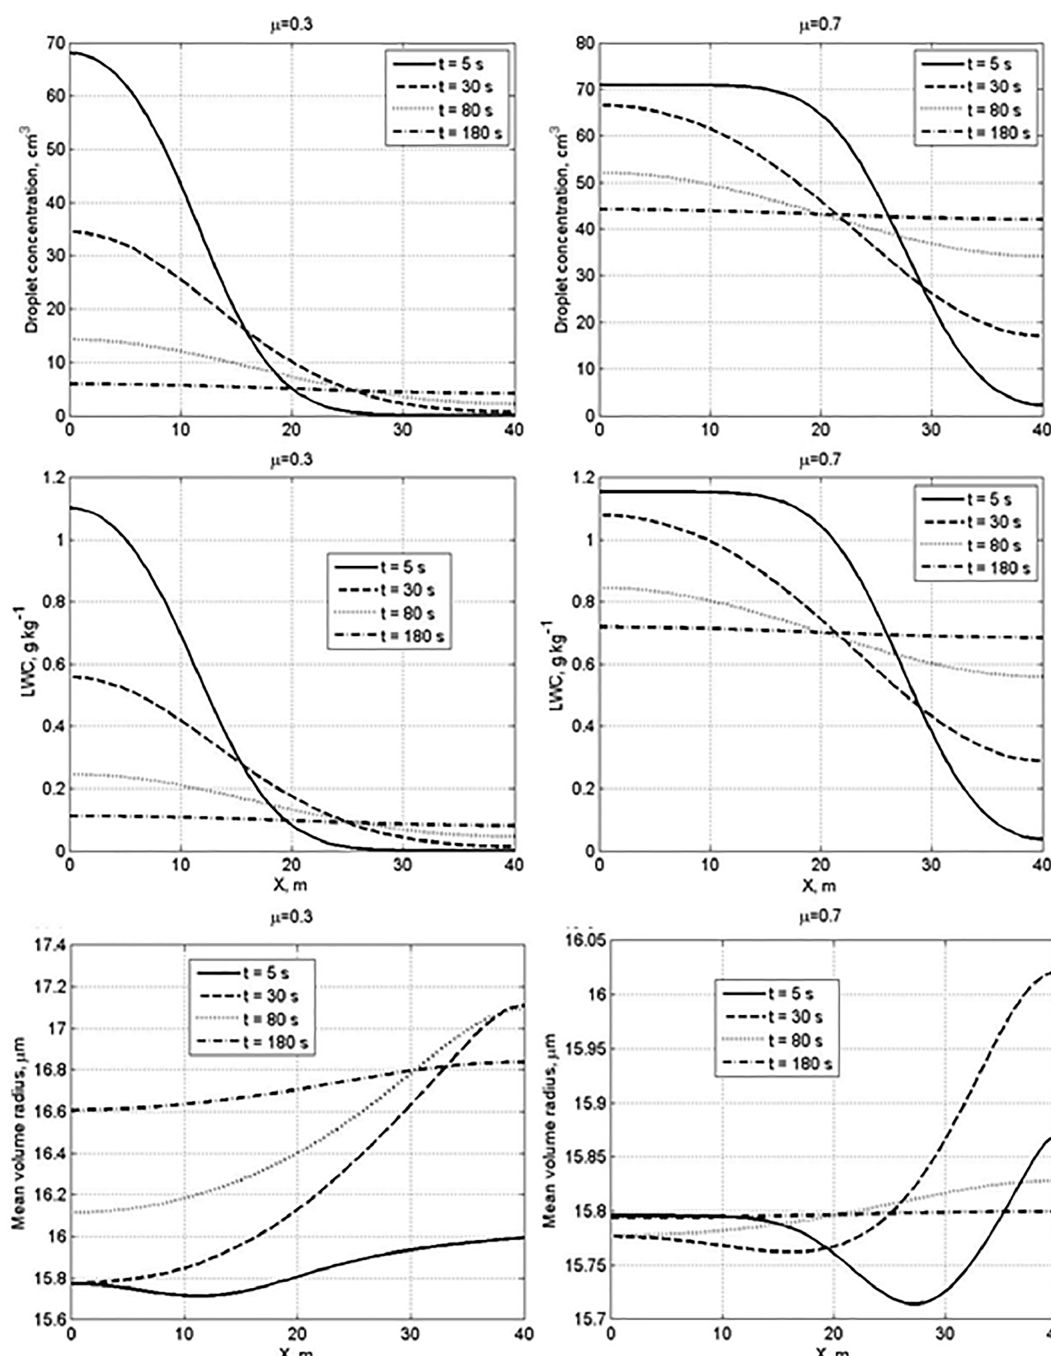
Figure 6. The same as in Fig. 5 but for wide DSD.